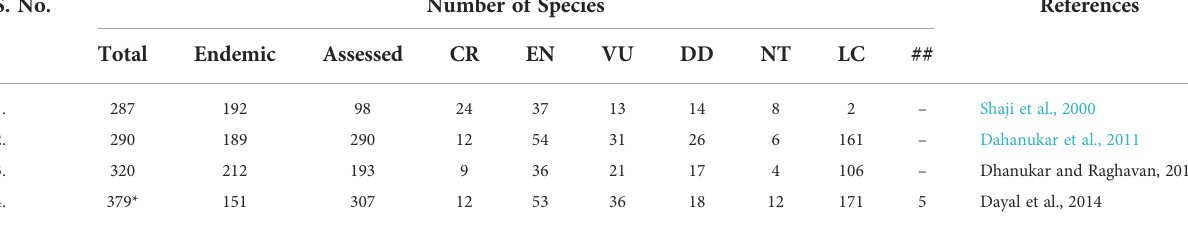
TABLE 3 Conservation status of endemic fi shes of Western Ghats at different periods. S.